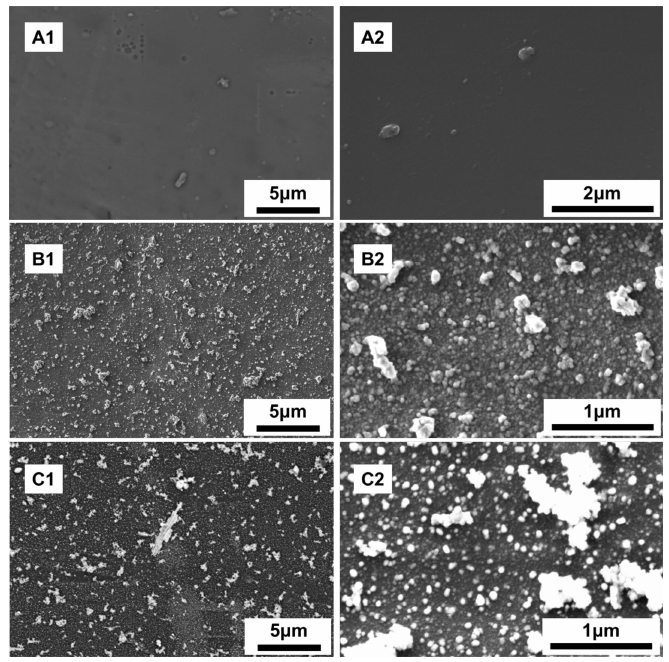
Figure 5: Figure 4. SEM images of the sample surface: ( A1 ) initial, ( A2 ) initial at higher magnification; ( B1 ) after sensitization, ( B2 ) detail of the magnified tin structures; ( C1 ) after activation, and ( C2 ) detail of the silver deposit.